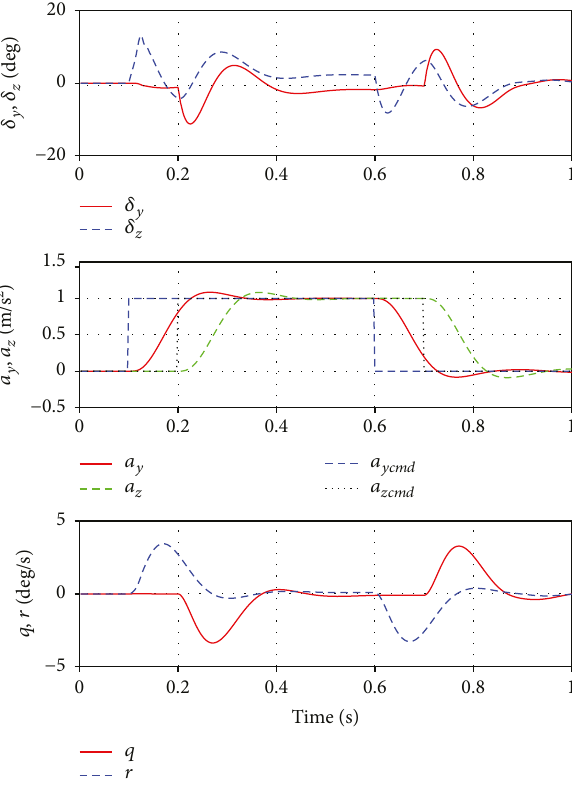
Figure 10: Control performance with Λ = 0 6 I